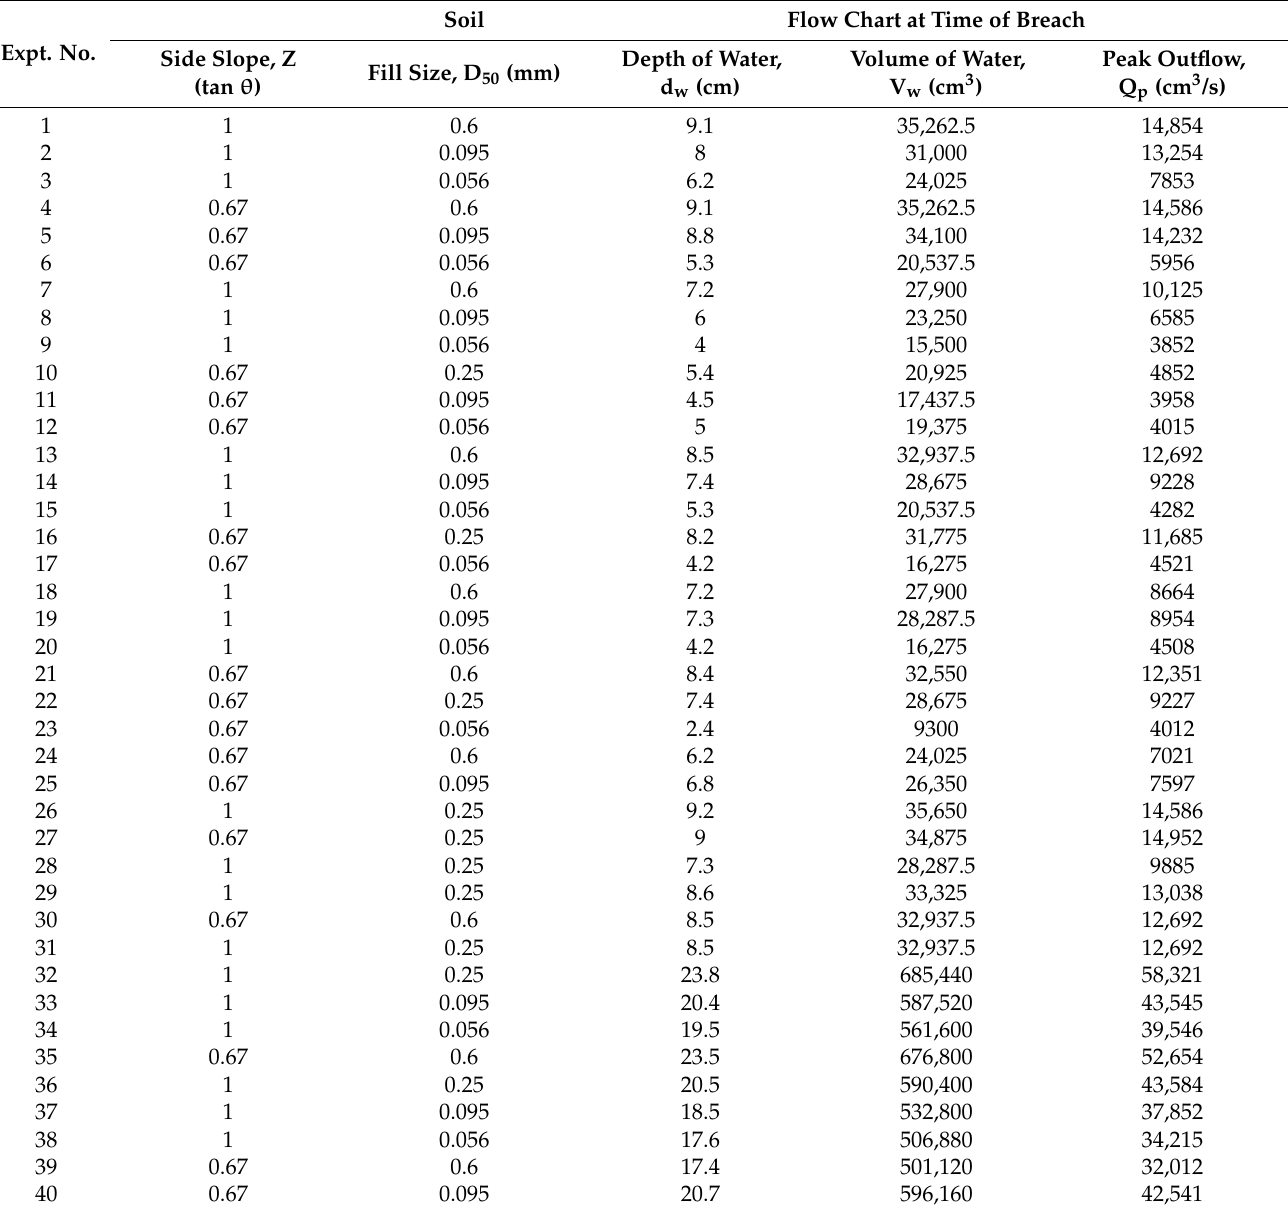
Table 2. Geometric, geotechnical, and hydraulic characteristics of embankment